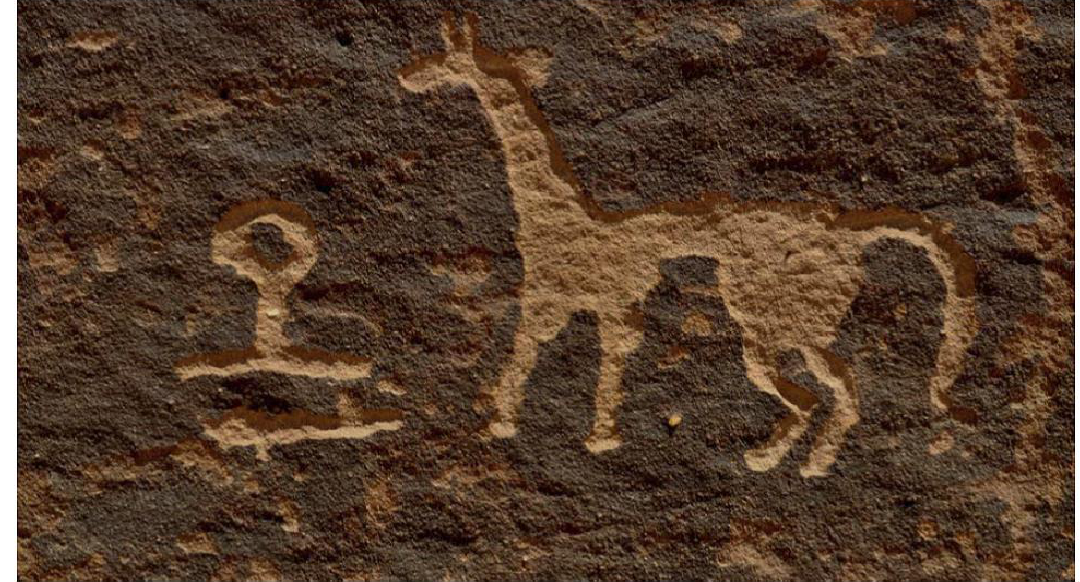
Figure 10. A horse figure associated with a tribal symbol, indicating the name of the tribe or person.